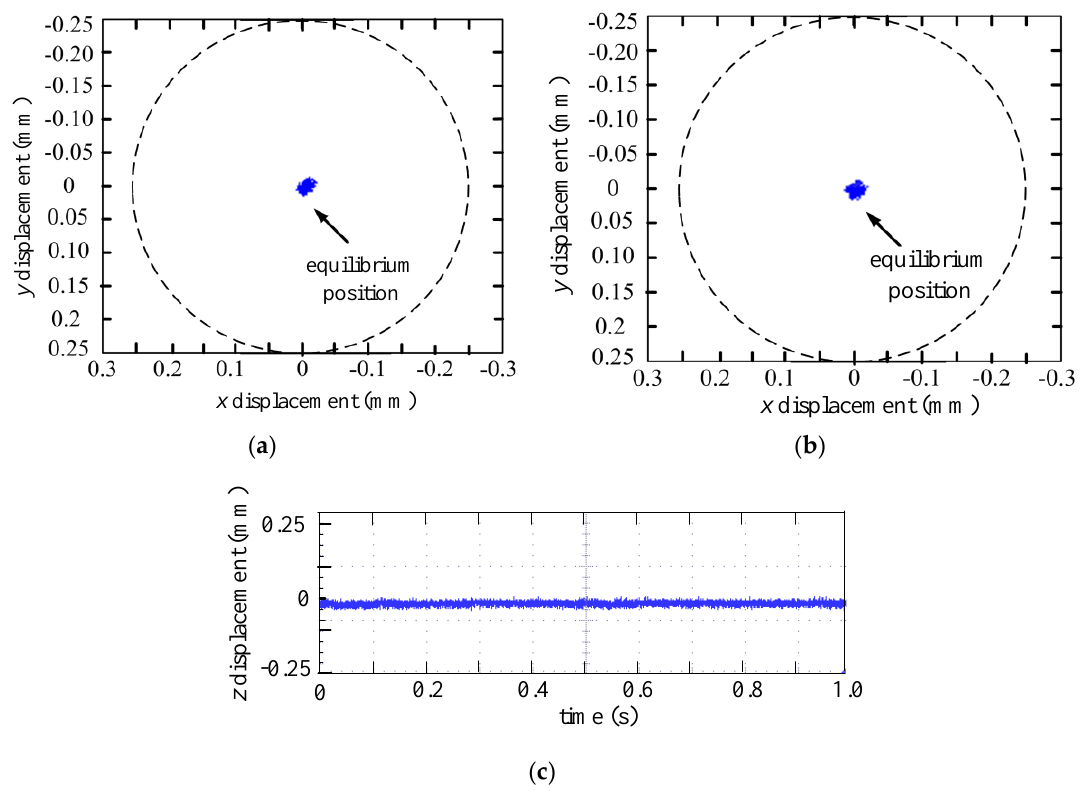
Figure 7. Radial trajectories of the rotor at the stable suspension state. ( a ) Mass center orbit of the suspended rotor under the support of the AC 2-DOF HMB; ( b ) Mass center orbit of the suspended rotor under the support of the AC–DC 3-DOF HMB; ( c ) Displacement waveforms of the rotor under the support of the AC–DC 3-DOF HMB.